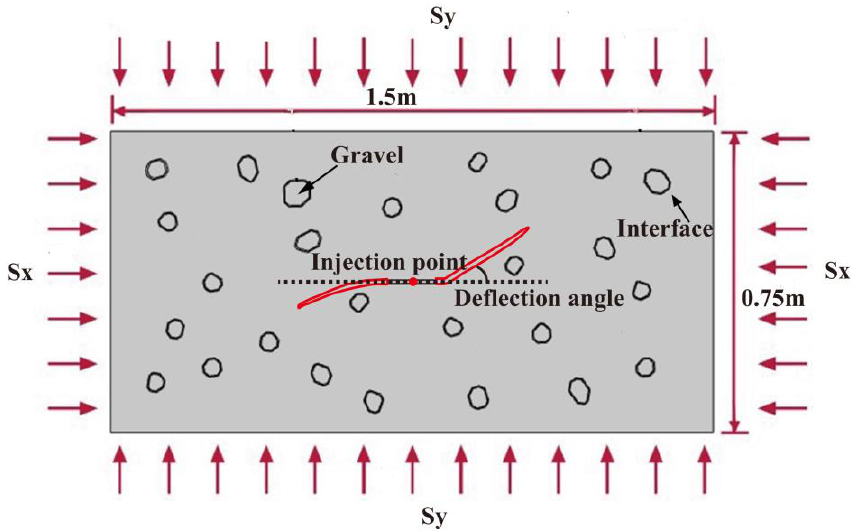
Figure 2. Illustrations of geometry containing gravels and weak interfaces and boundary conditions.